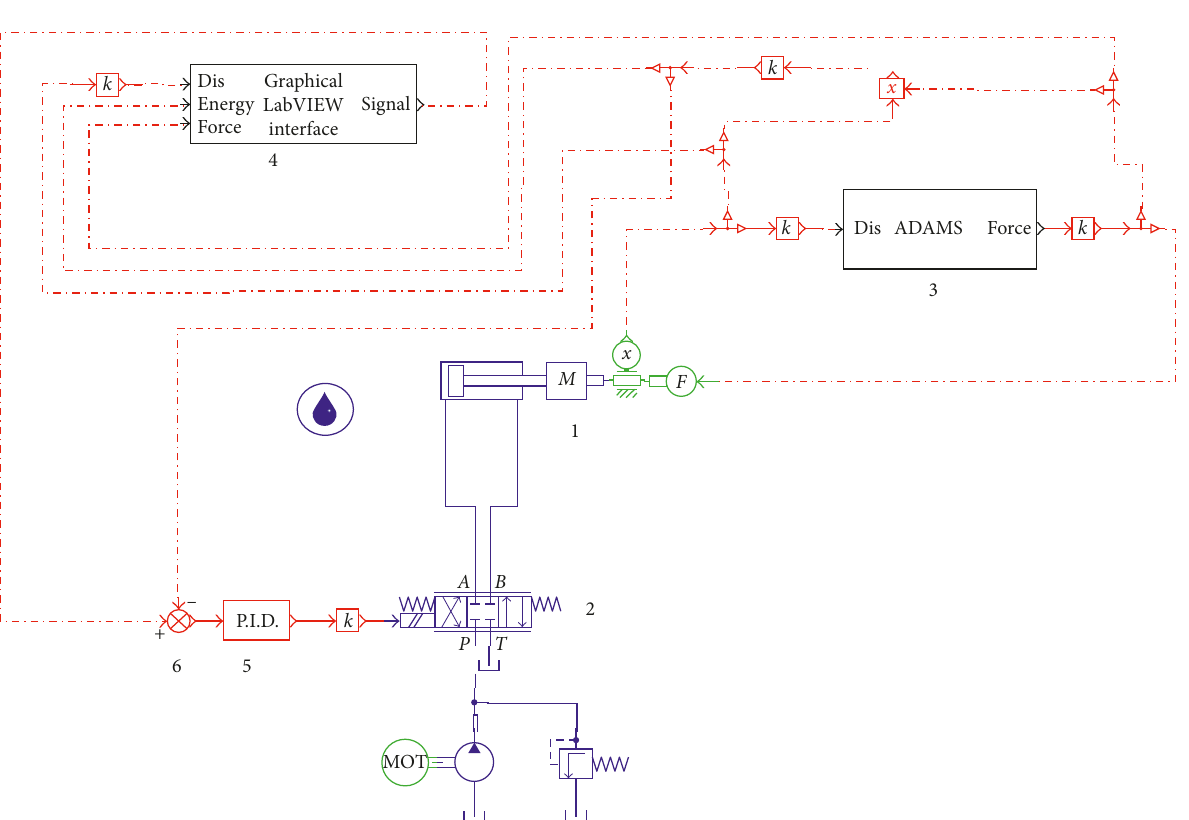
Figure 7: Mechanical-hydraulic control cosimulation system: 1, hydraulic cylinder; 2, solenoid valve; 3, interface of ADAMS-AMESim; 4, interface of LabVIEW-AMESim; 5, PID module; 6, signal input port.